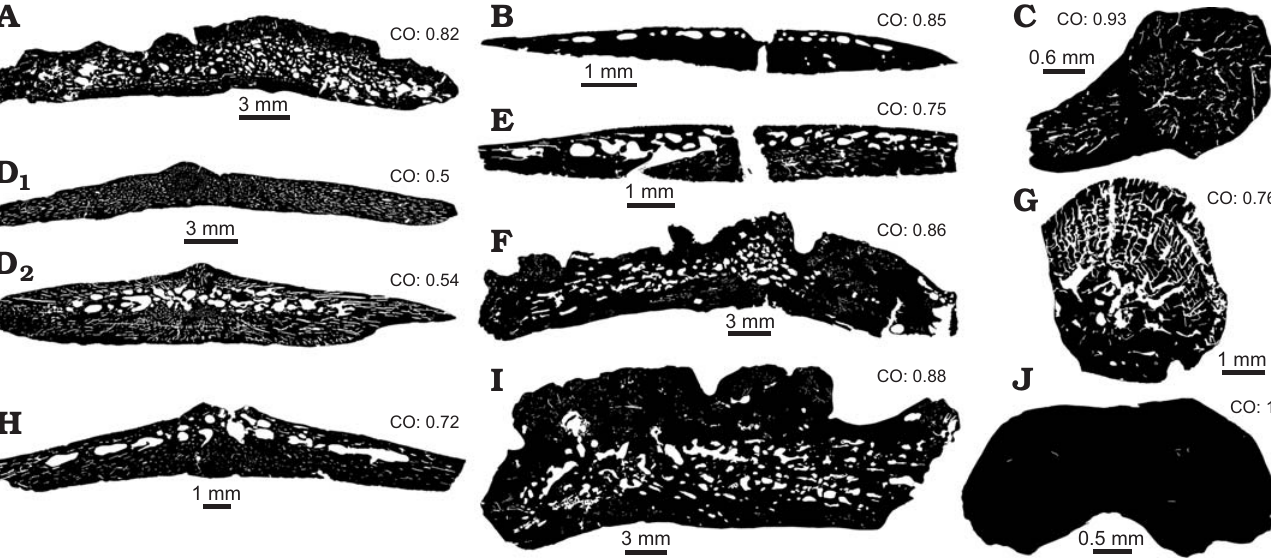
Fig. 2. Compactness degree obtained from all osteoderms of examined taxa and comparison with others Doswellidae and Proterochampsidae taxa. A . Doswelliid Doswellia kaltenbachi Weems, 1980, USNM PAL 244214 from Near Doswell, Virginia, USA, Carnian. B , D , E , G . Doswelliid Vancleavea campi Long and Murry, 1995 from Coelophysis Quarry, “Siltstone Member” (GR 138) and Hayden Quarry, Petrified Forest Member (H4-102-08), Chinle Formation, New Mexico, USA, Early Norian. B . GR 138 (1). D . GR 138 (2A, D 1 ; 2B, D 2 ). E . GR 138 (V1). G . H4-102-08 (V2). C , F .